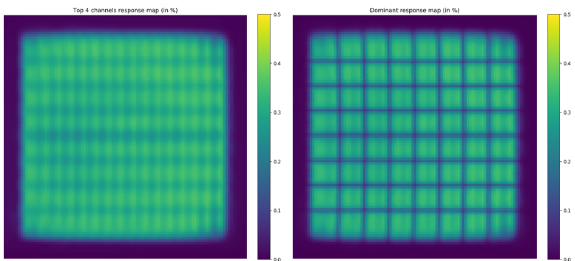
Figure 5. Left: “top-4” channel response map. Right: “maxi- mum response map”. The Figure reveals that border pixels are larger than central ones – causing “border e ff ects” in full illumi- nation mode. PMT22 of PDM2, λ = 405 nm, 100 × 100 points resolution.